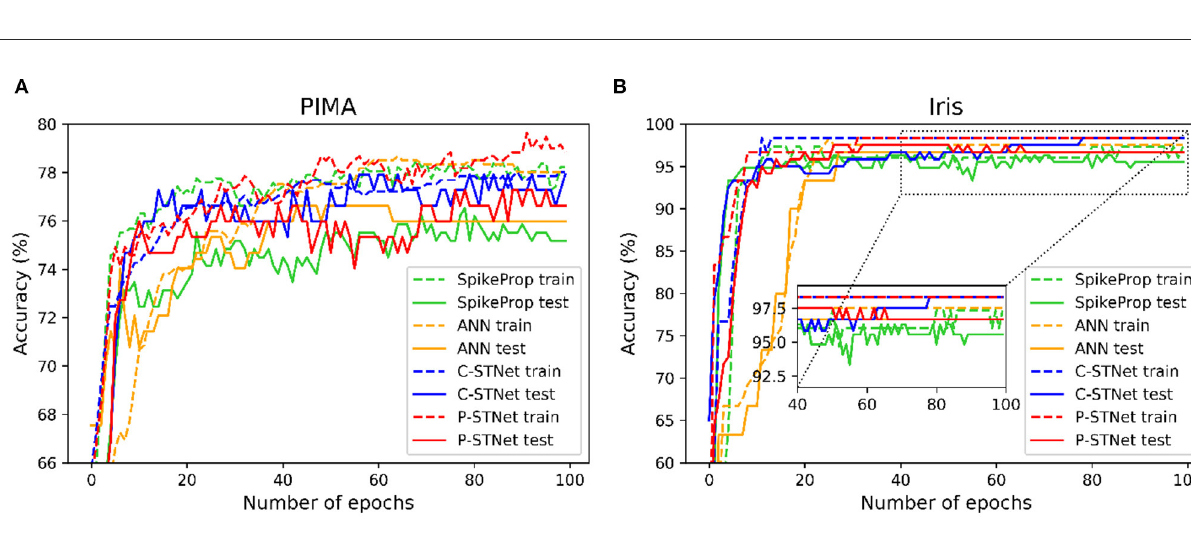
C-STNet and the P-STNet performed well in terms of convergence speed and